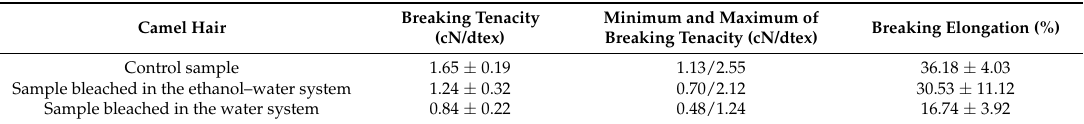
Table 2. Mechanical properties of camel hair bleached in the water and ethanol–water